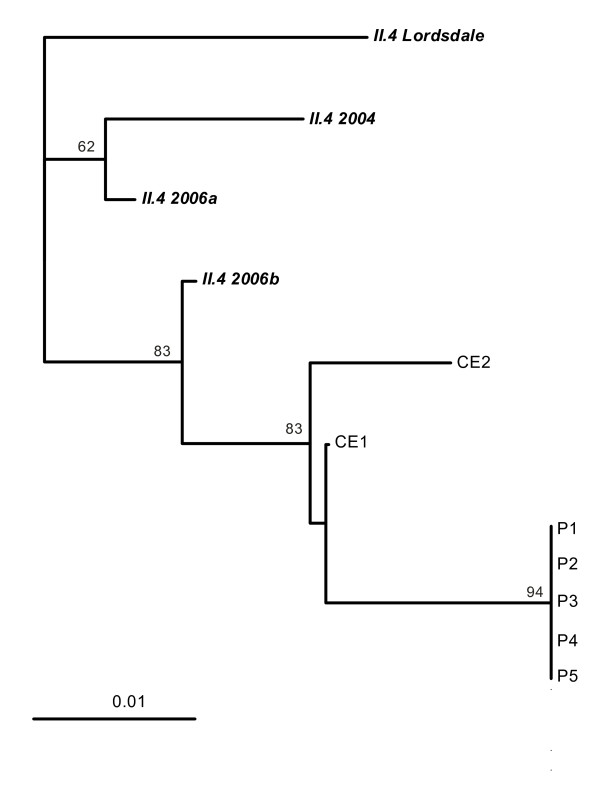
Neighbour-joining tree of 215 bp amplificates of the ORF1/2 junction of norovirus. P1 to P5 are sequences from stool specimens of patients and CE1 and CE2 from canteen employees. Prototype sequences in bold and italics are from GenBank: II.4 Lordsdale, X86557; II.4 2004 DenHaag54, EF126962; II.4 2006a Terneuzen70, EF126964; II.4 2006b Nijmegen115, EF126966. Bootstrap values > 60% are indicated. The scale represents nucleotide substitutions per site.